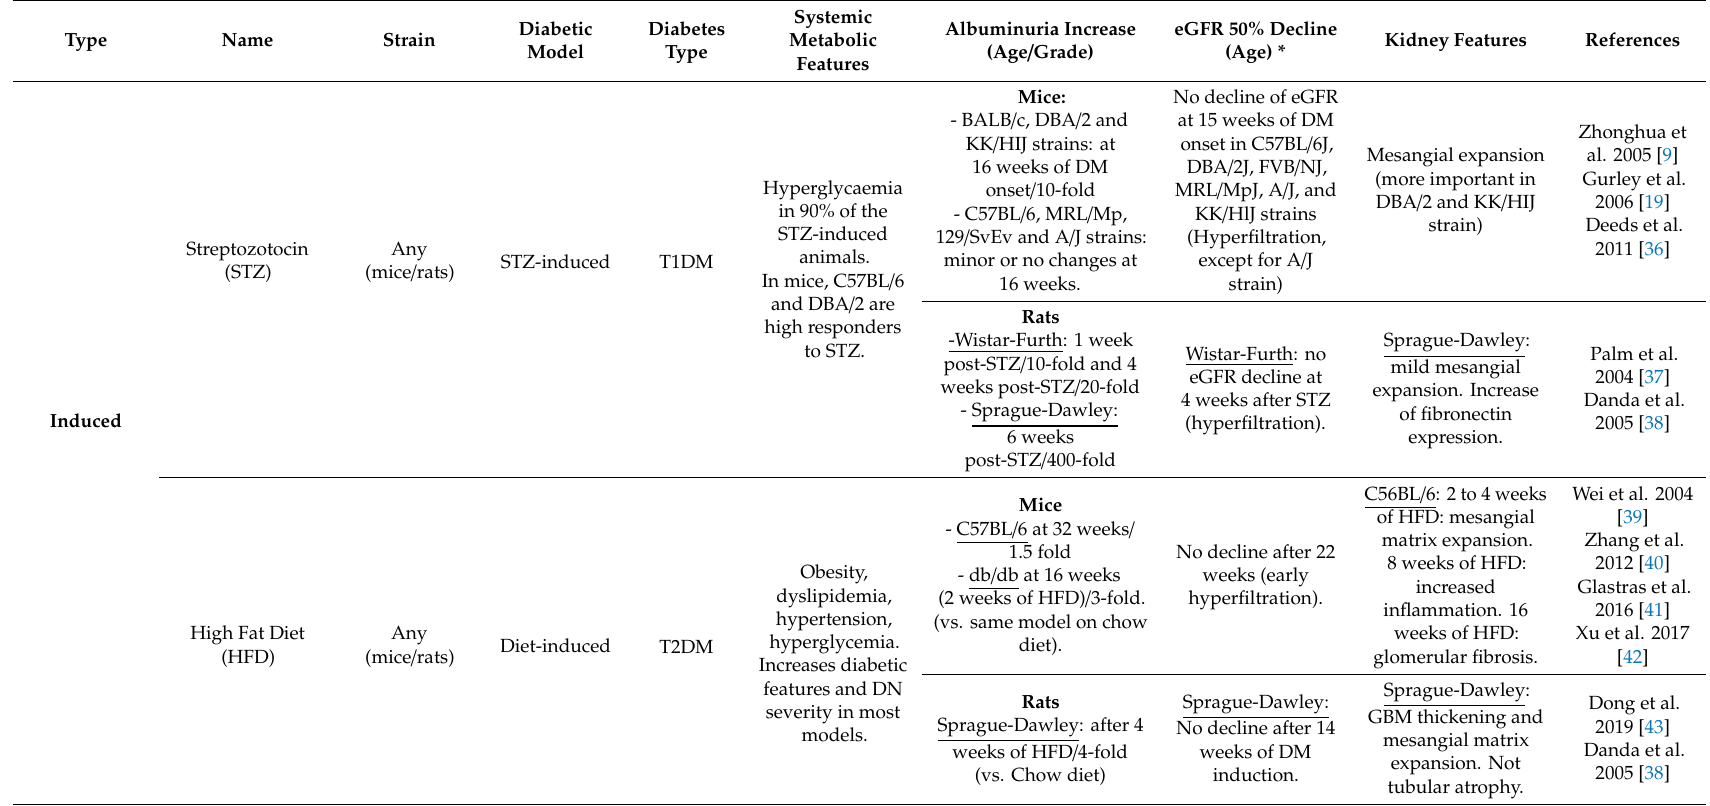
Table 2. Experimental models of diabetic nephropathy